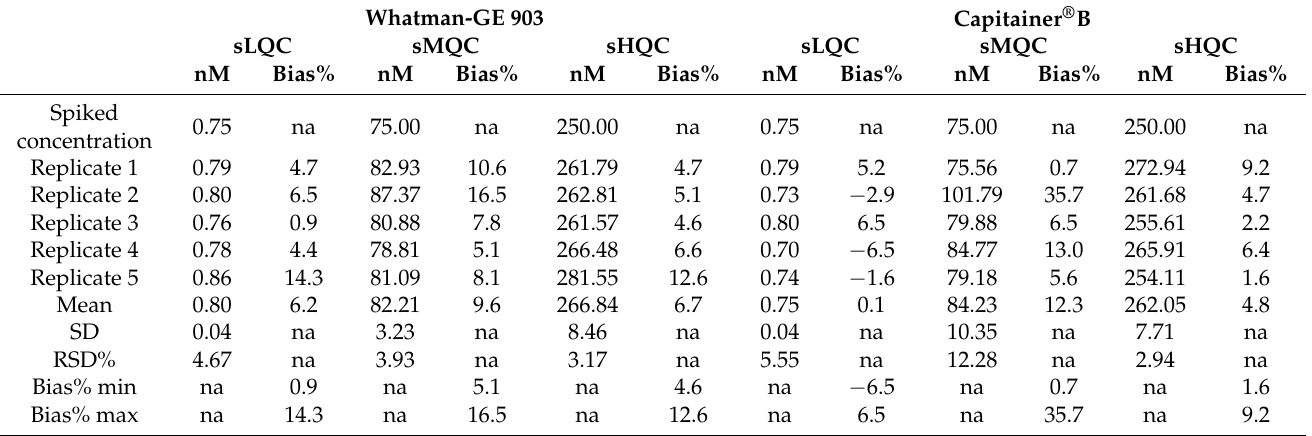
Table 1. Intra-day assays ( n = 5) performed with spiked quality control (sQC) dried blood spots (DBSs) prepared at three concentration levels by spiking lyso-Gb 3 - 13 C 6 in a pool of blood from control